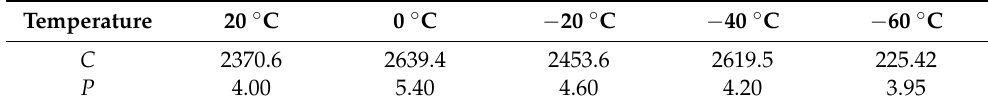
Table 2. C and p values at different temperatures.